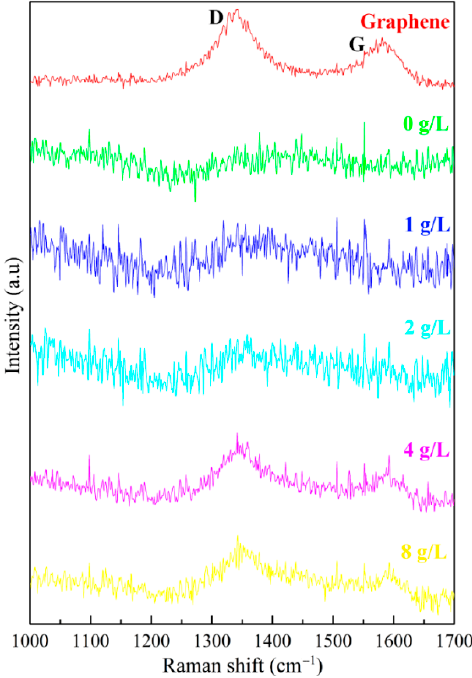
Figure 5. Raman spectra of the Ni–Cr–graphene coatings with different concentrations of graphene.